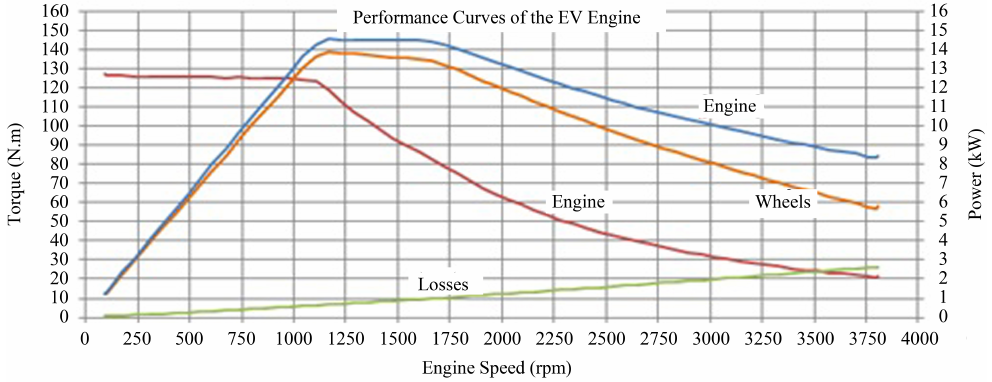
Figure 10. Different tests carried out on the roll bench.